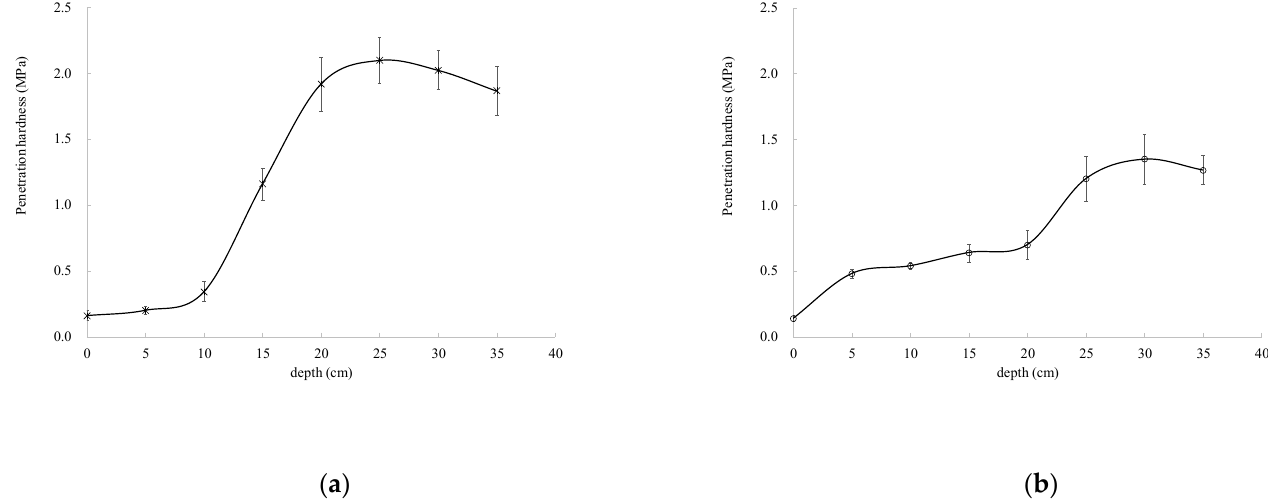
Figure 1. Soil penetration hardness of test fields. ( a) Takata field. ( b) Yonesaki field. Vertical bars indicate standard error ( n = 3).